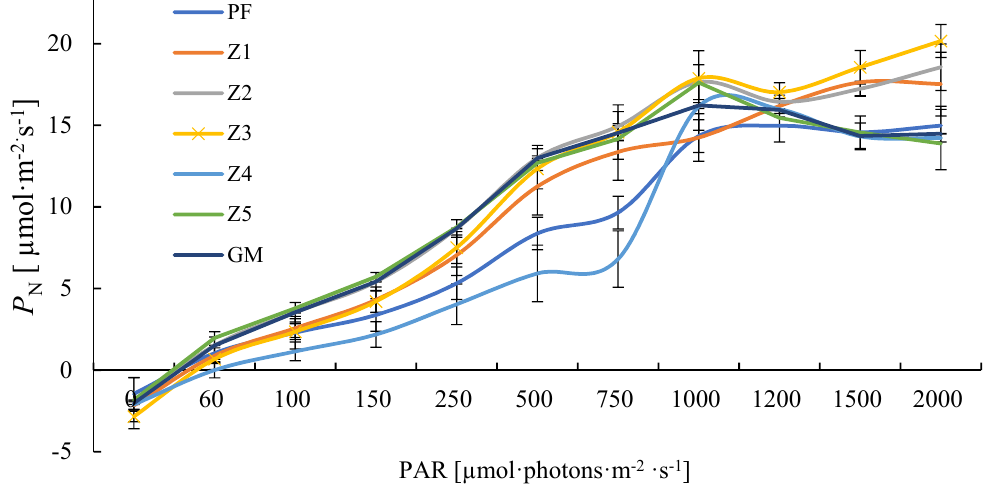
Figure 1. Light response curve of P N of different materials. Note: PF—purple female; GM—green male. Means of 10 replications ± SE.